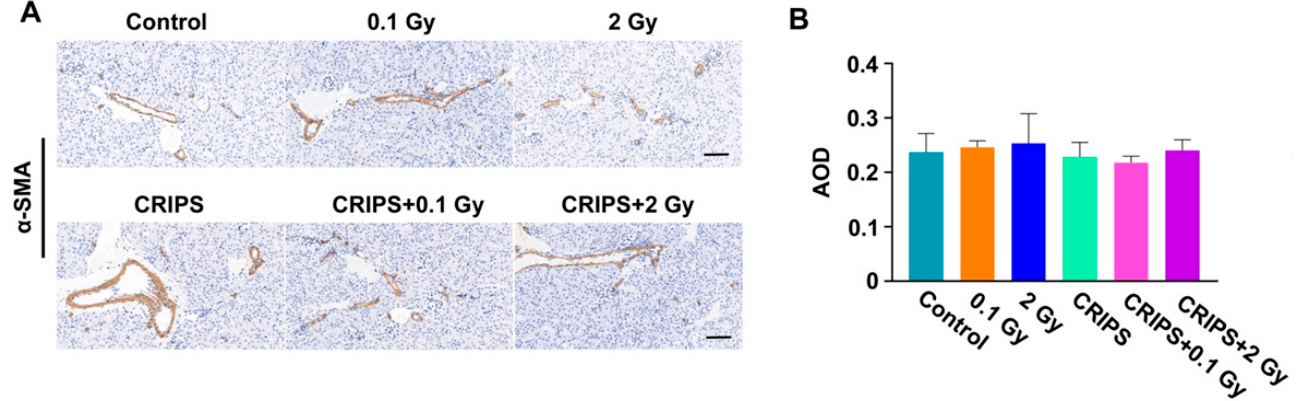
Figure 6. Expression of α -SMA, detected in renal sections in Trp53 +/ − mice. ( A ), the expression of α -SMA was analyzed by immunohistochemistry (magnification, 200 × ; scale bar = 100 µ M); ( B ), the average AOD of α -SMA in each group. CRIPS, chronic restraint-induced stress; AOD, the average optical density (Integrated optical density/area).